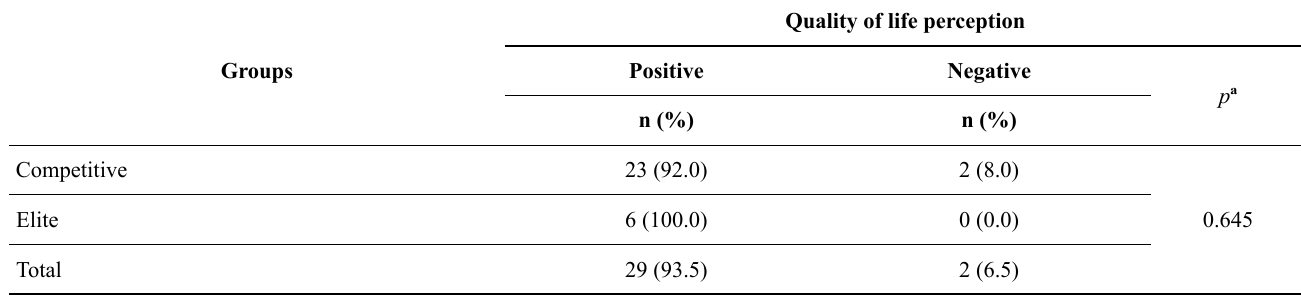
Table 3. Quality of life perception according to the competitive level